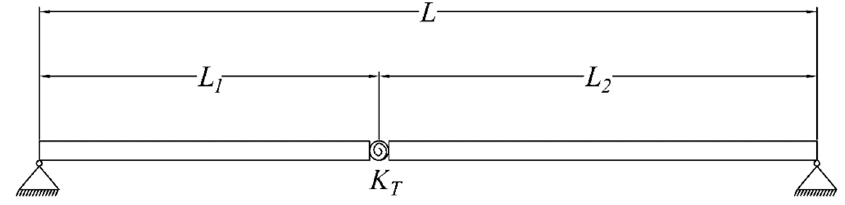
Figure 1. Simply supported beam segment with a slope discontinuity at station 𝐿 (cid:2869) .